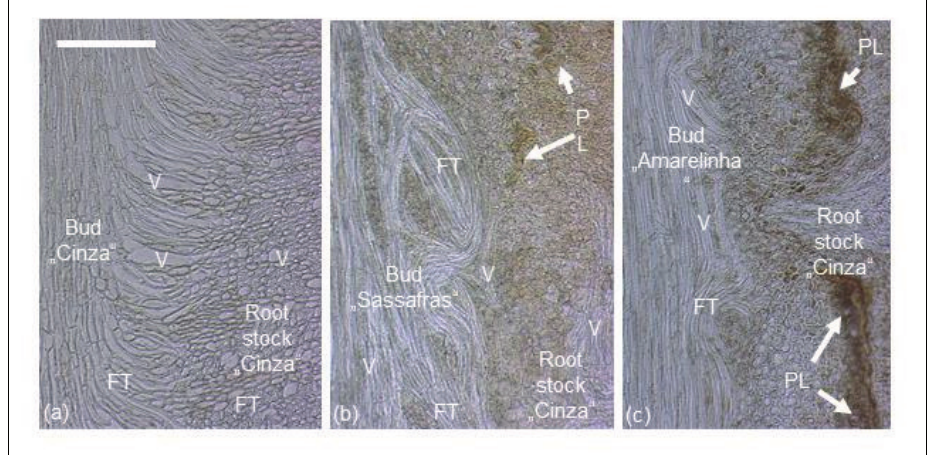
Fig. 5a-c: Wood structure of the connecting zone between the root stock of the phenotype “Cinza” and the bud of (a) the phenotype “Cinza”, (b) the pheno- type “Sassafras”, and (c) the phenotype “Amarelinha” six months after grafting. FT = fibre tracheids, PL = protective layer, V = vessel. Scale bar = 200